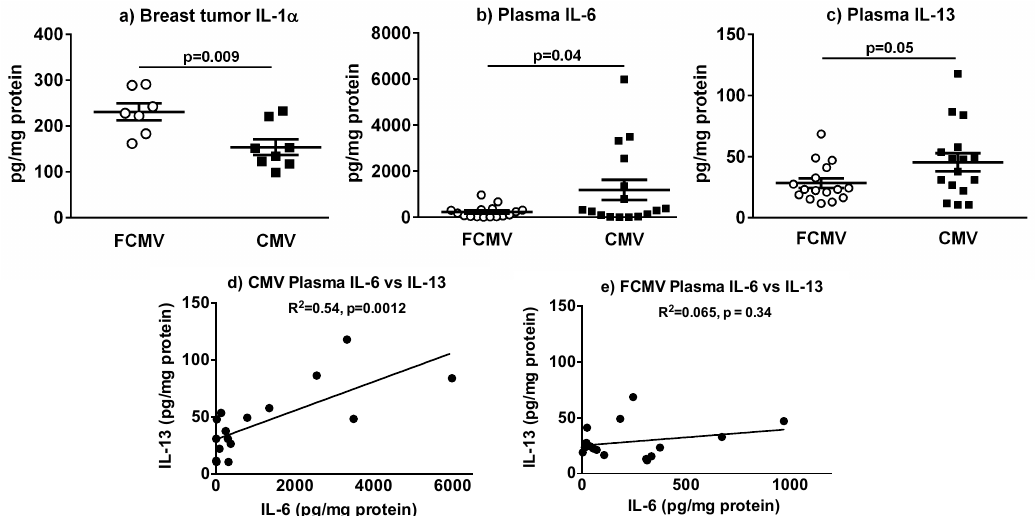
Figure 7. Cytokine concentrations differed in breast tumors and plasma from MMTV-PyVT mice latently infected with mCMV. Breast tumor levels of IL-1 α , n = 8 ( a ). Plasma concentrations of IL-6 ( b ) and IL-13 ( c ), n = 16. The regression analysis of plasma concentrations IL-6 versus IL-13 in mCMV-infected ( d ) and mice treated with a filtered control solution (FCMV) ( e ). The p -values were calculated by Student’s t -test.